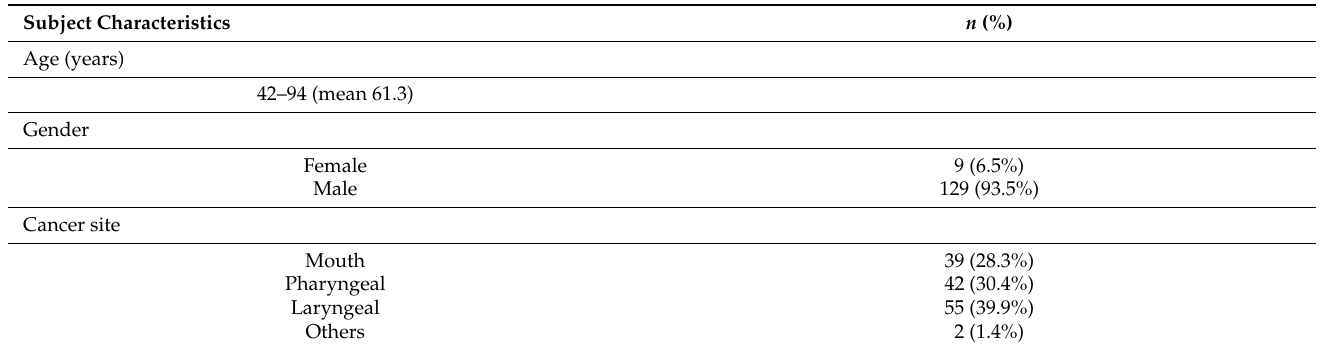
Table 2. Subject characteristics.